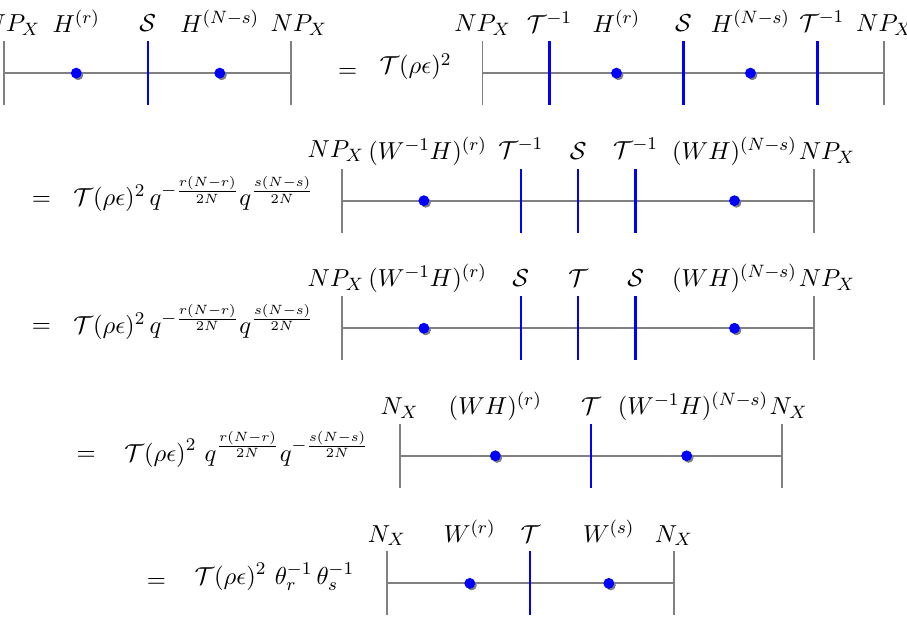
Figure 20 . An evaluation of Z